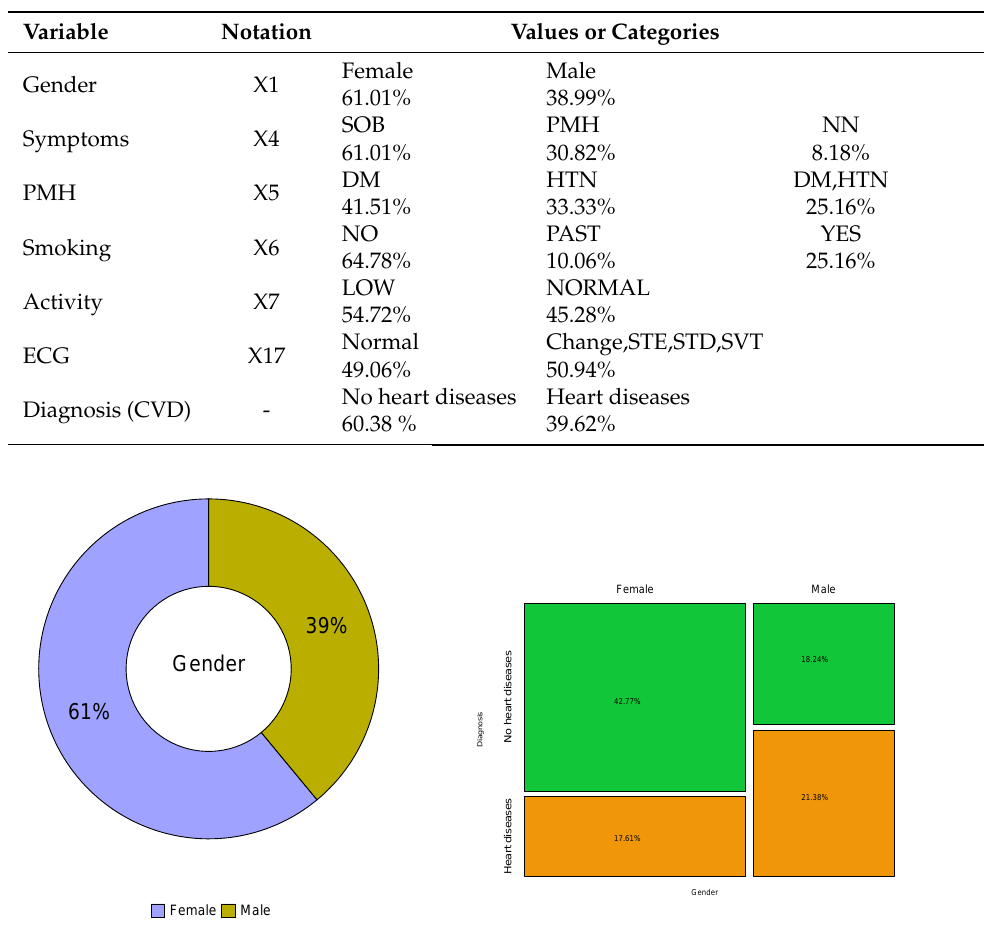
Figure 4. Distribution of the patients by gender ( left ) and gender versus diagnosis ( right